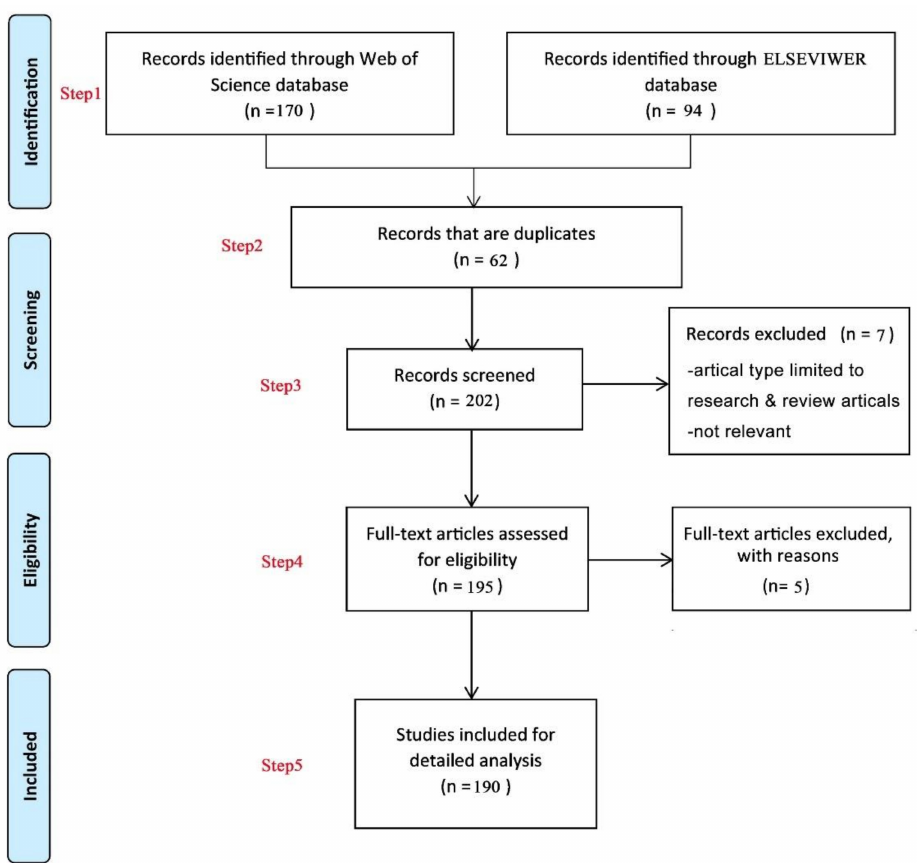
Figure 2. Flow chart of the literature selection and review process for the WoS and Elsevier databases using the initial